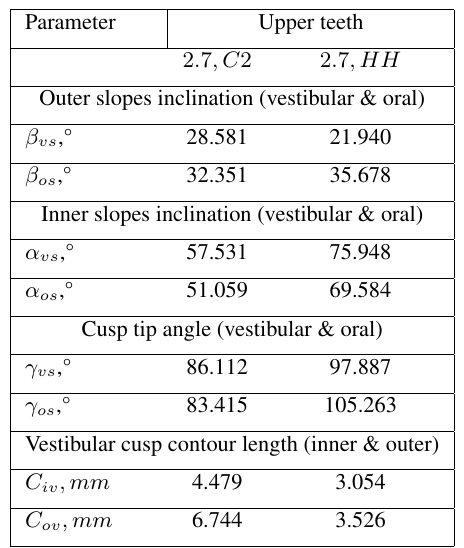
Table 1. Odontometric parameters for upper teeth